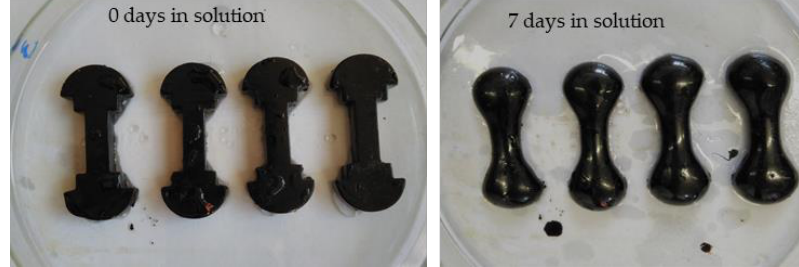
Figure 6. Change in the shape of the asphalt binder test samples (Photo: Authors).